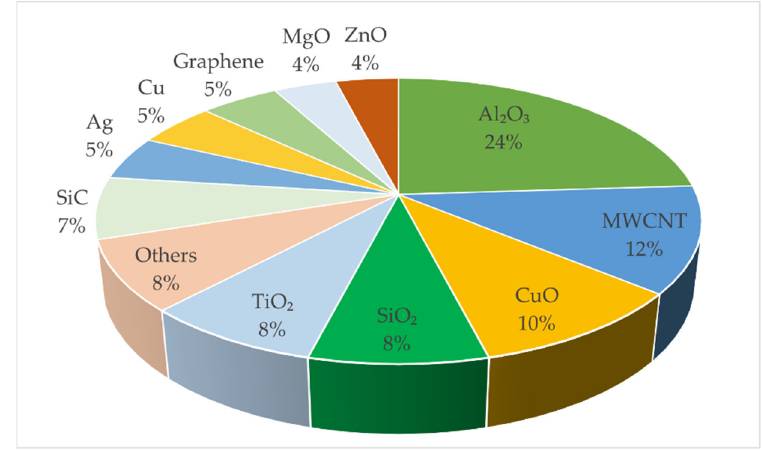
Figure 16. Research on nanoparticles in PVT systems. Reproduced with permission from ref. [34]. 2021. Sheikholeslami et al.